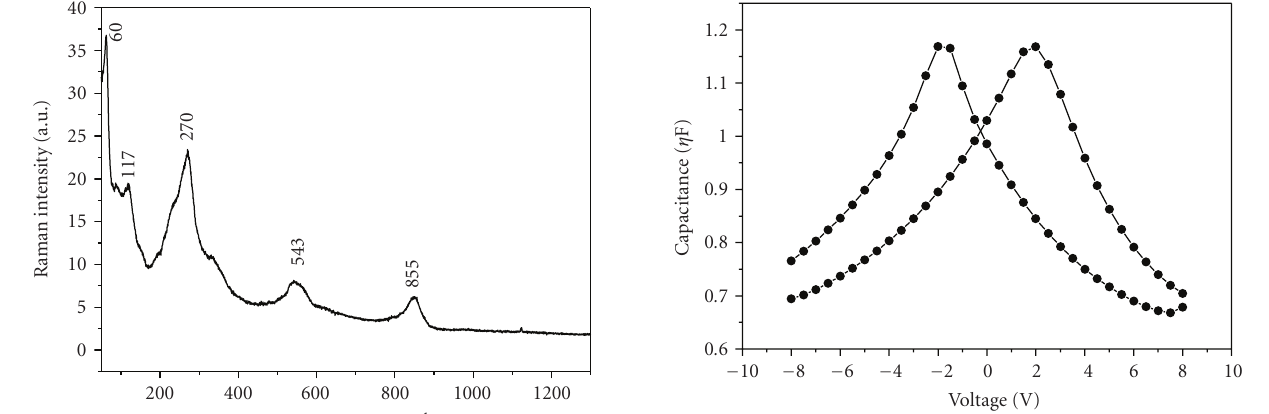
Figure 2: Micro Raman spectra of SBTi film annealed deposited by the soft chemical method at 700 ◦ C for 2 hours.